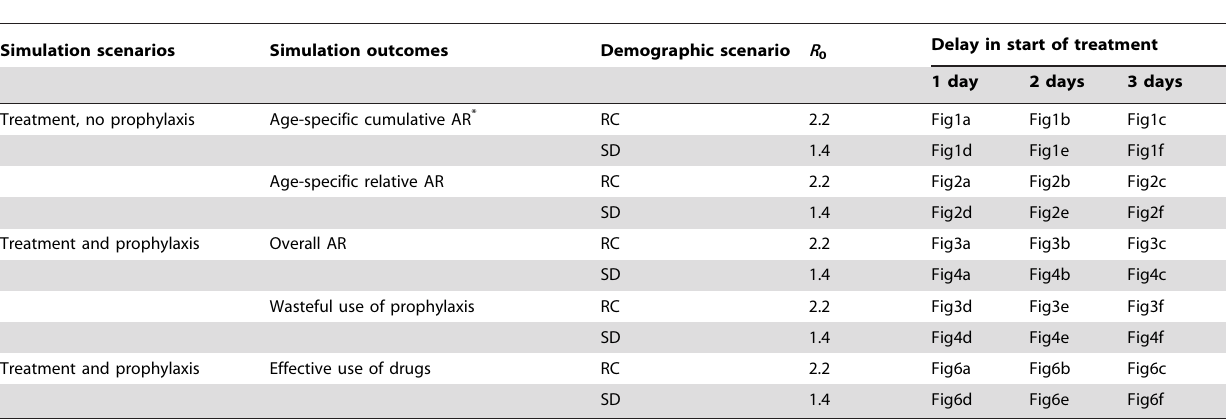
Table 1. Simulation scenarios presented for treatment and prophylaxis strategies, when prophylaxis was implemented for 3